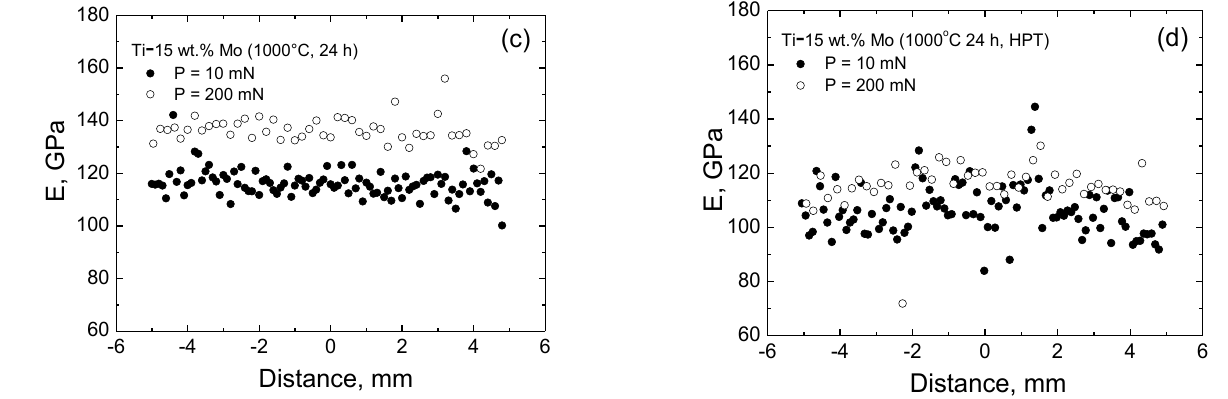
Figure 9. The dependences of nano- and microhardness H ( a , b ), as well as Young’s modulus E ( c , d ) on the distance across the sample (0 corresponds to the disc center) for the Ti – 15 wt.% Mo alloy before and after HPT.